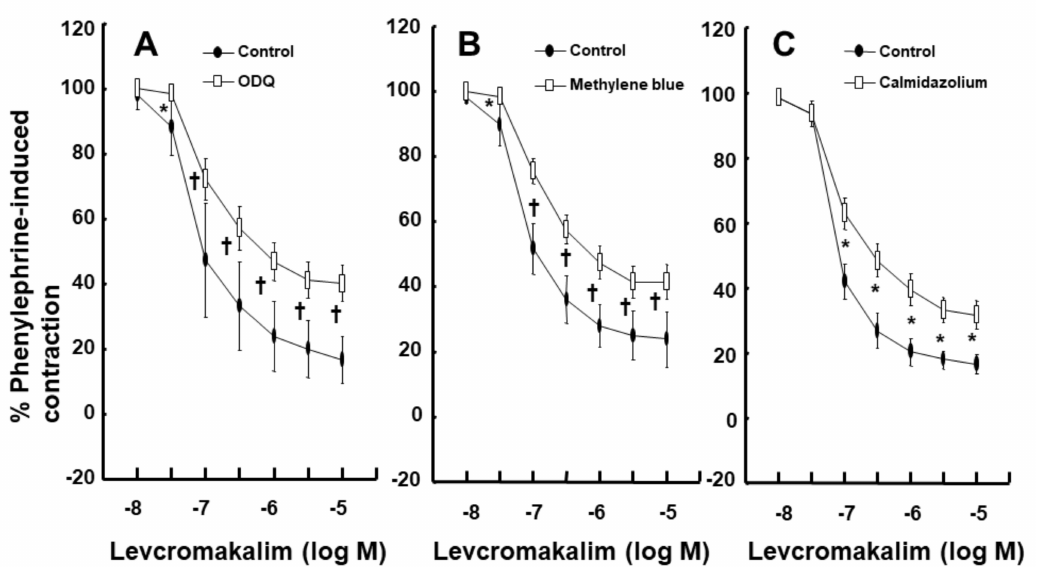
Figure 5. E ff ect of 1H-[1,2,4]oxadiazolo[4,3-a]quinoxalin-1-one (ODQ, 10 − 6 M, A , n = 8), methylene blue (10 − 6 M, B , n = 8) and calmidazolium (3 × 10 − 5 M, C , n = 8) on the levcromakalim-induced vasodilation of isolated endothelium-intact rat aortae. Data are shown as the mean ± SD and expressed as the percentage of maximal contraction induced by phenylephrine (10 − 6 M). n indicates the number of isolated rat aortae. A: * p < 0.05 and † p < 0.001 versus control. B: * p < 0.01 and † p < 0.001 versus control. C: * p < 0.001 versus